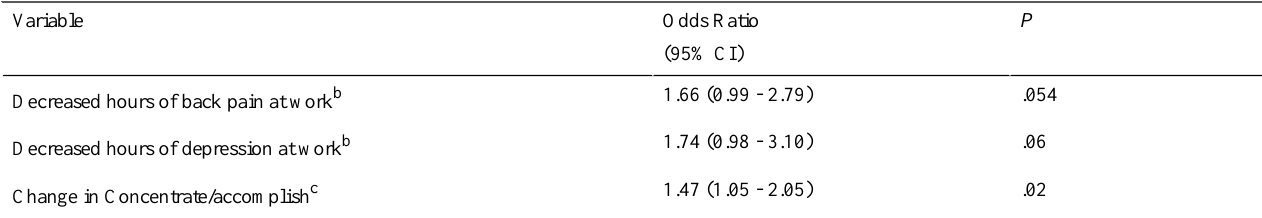
Table 4. Effect of Alive! on presenteeism a : change in the intervention group vs change in the control